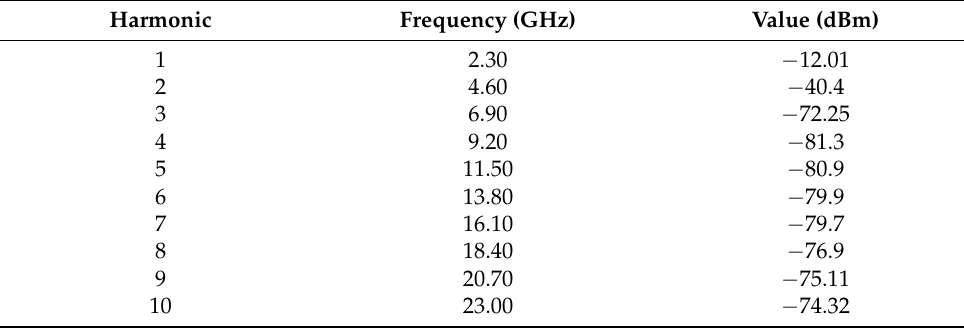
Table 4. Harmonics generated by the RABE at 2.30